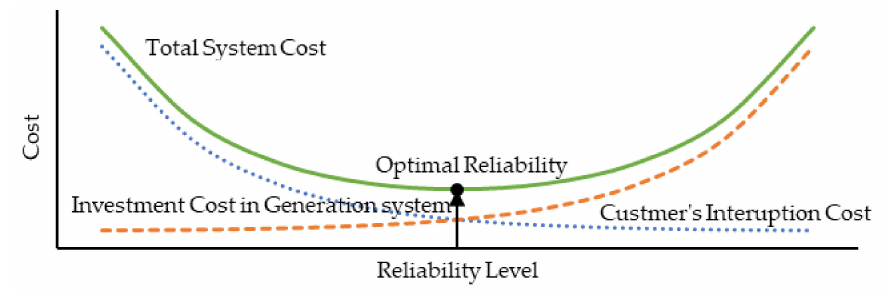
Figure 1. Concept of optimal reliability criteria determination with minimum